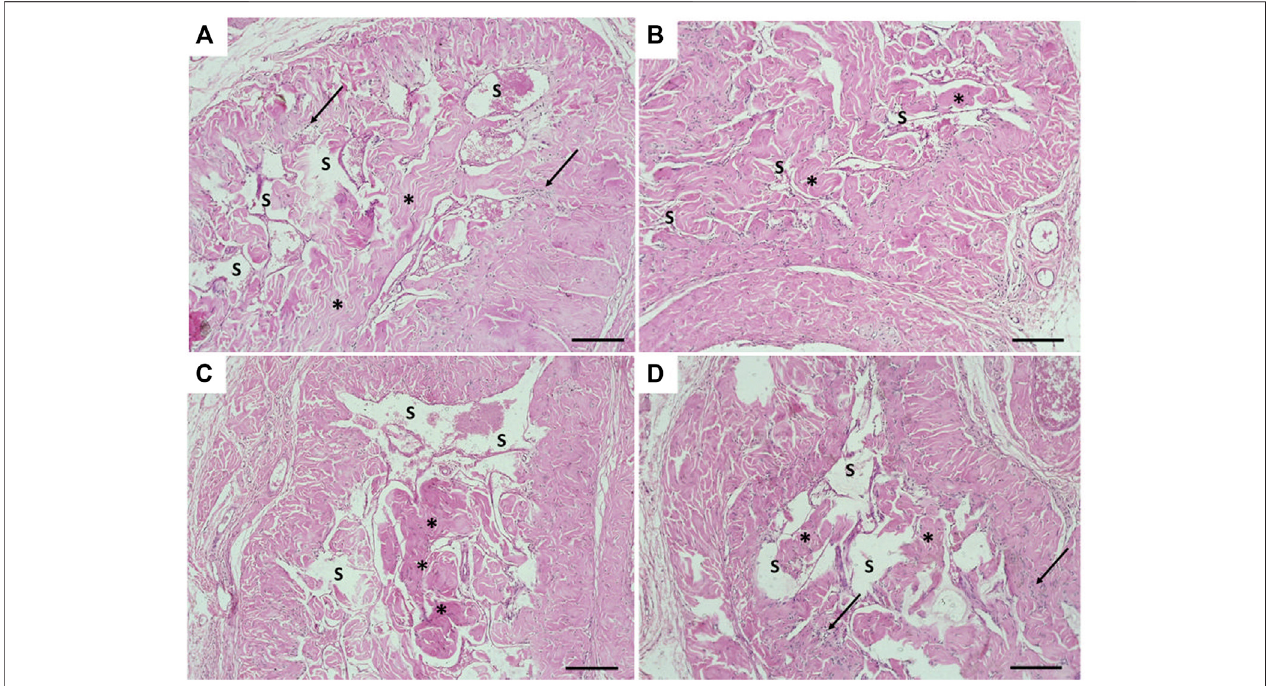
FIGURE 5 | Histological transverse sections of the penises of all rats in all groups. (A) Corpus cavernosum in the control group (group I) appeared with wide cavernous spaces and formed by smooth muscles and collagen fi bers. (B) Narrowing of the cavernous spaces the in diabetic group (group II). (C) and (D) showing almostrestorationofcavernousspacesingroupsIIIandIV,respectively.CS:cavernousspaces.Arrow:Smoothmuscles.Asterisk:collagen fi bers.H&EX100.Scalebar: 100 μ m.